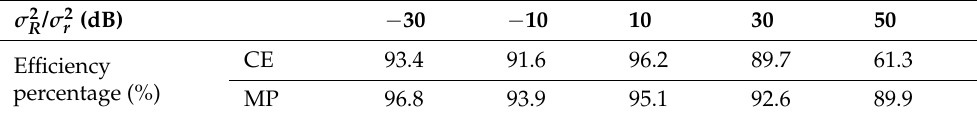
Table 3. Efficiency percentage comparison table for CE and MP methods (Simulation 3).